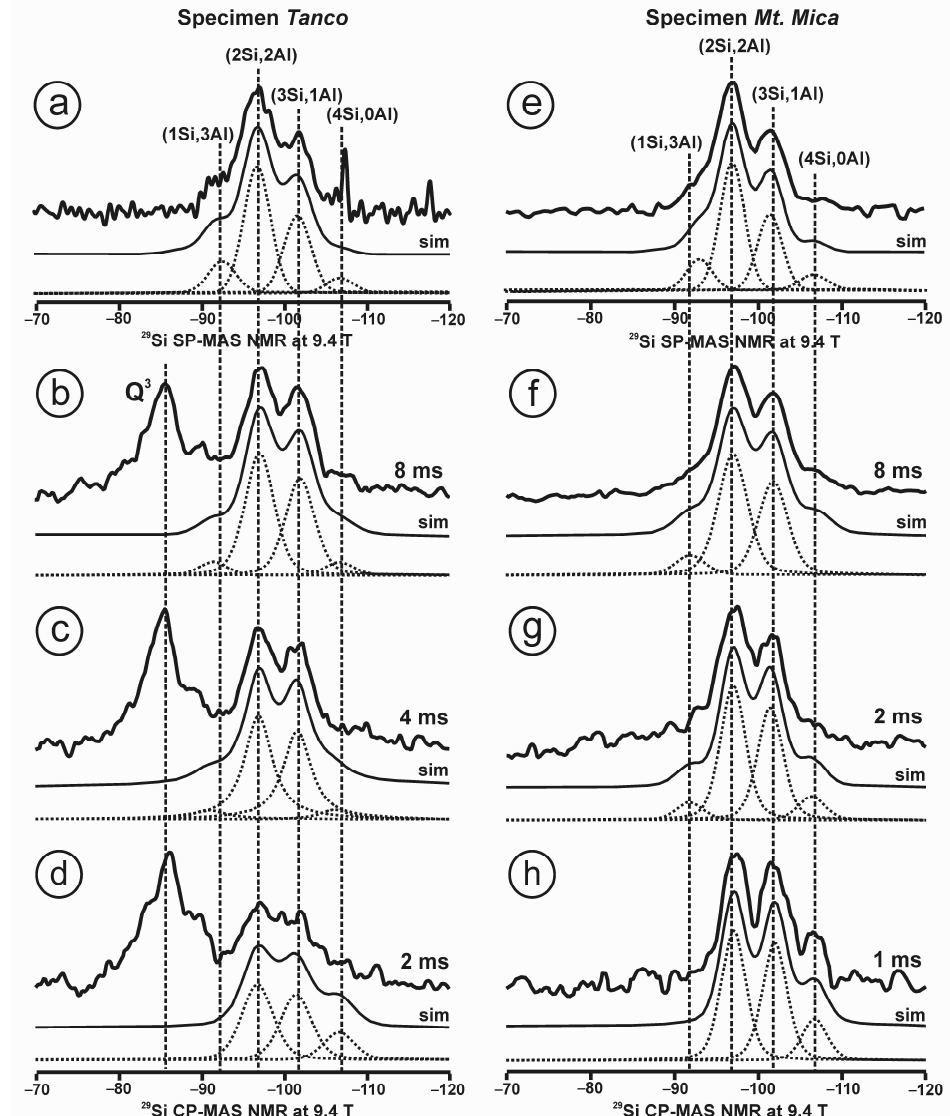
Figure 4. The 29 Si MAS NMR spectra at 9.4 T of the two specimens of pollucite using single-pulse SP-MAS experiments in ( a ) for specimen Tanco and ( e ) for specimen Mt. Mica . The CP-MAS experiments for specimen Tanco in ( b ) at 8 ms, ( c ) at 4 ms and ( d ) at 2 ms of contact time and D 0 or recycling time of 3 s, in all cases with 34,816 scans. The same spectra for specimen Mt. Mica in ( f ) at 8 ms, ( g ) at 2 ms, and ( h ) at 1 ms of contact time, and D 0 = 3 s, in all cases with 40,960 scans. Only four of five possible chemical environments are recorded (vertical dotted lines) of the Q 4 n (4-nSi,nAl) for n = 0, 1, 2, 3 and 4. The experimental spectra are compared with the simulated curves (sim) from the addition of the four detected chemical environments using Voigt curves (xG/(1 − x)L = 0.7). The numerical values of the areas in % of the simulated spectra are in Tables 3–6, in comparison with the expected values for the random (RD) and Loewenstein (LD) models. Q 3 is a wide resonance centered at ~ − 85 ppm from phyllosilicate impurities.